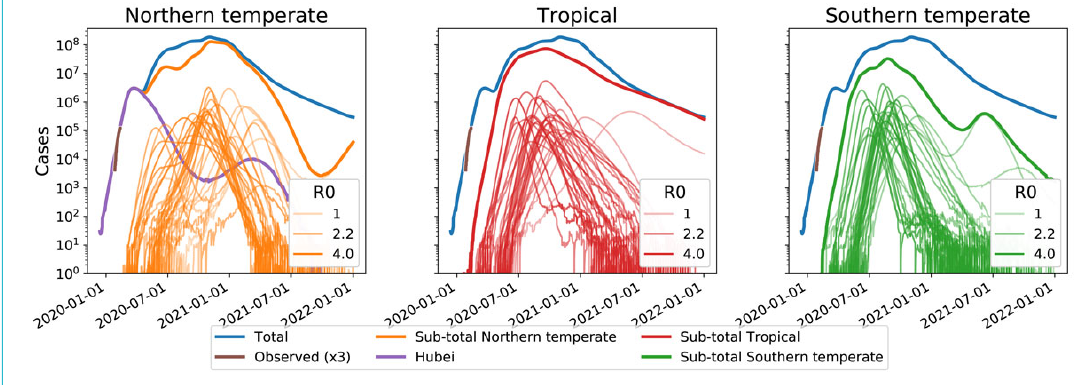
Figure 4: Extended circulation through overlapping epidemics in variable subpopulations. These simulations of a pandemic scenario assume 1,000 sub-populations with an average ‹R 0 › of 2.2 and standard deviation 0.5, 40% of which have weak seasonal forcing ε ∈ [0, 0.2] (tropical) and the remainder have strong variation with ε ∈ [0.25, 0.75]. The super-position of many variable epidemics can result in a global prevalence that decays only slowly through 2020 and 2021. Lighter lines have lower R 0 , darker lines have higher R 0 . The actual observed case counts re- ported for Hubei are added (brown line) and multiplied by three to account for possible under-reporting of mild cases. A subset of 30 randomly chosen simulations are plotted for each region. Analogous figures for different R 0 parameter values are shown in figure S7 (appendix 1).